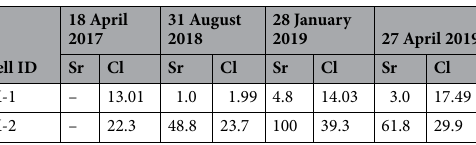
Table 1. Calculated mixing ratios of the formation water in the well